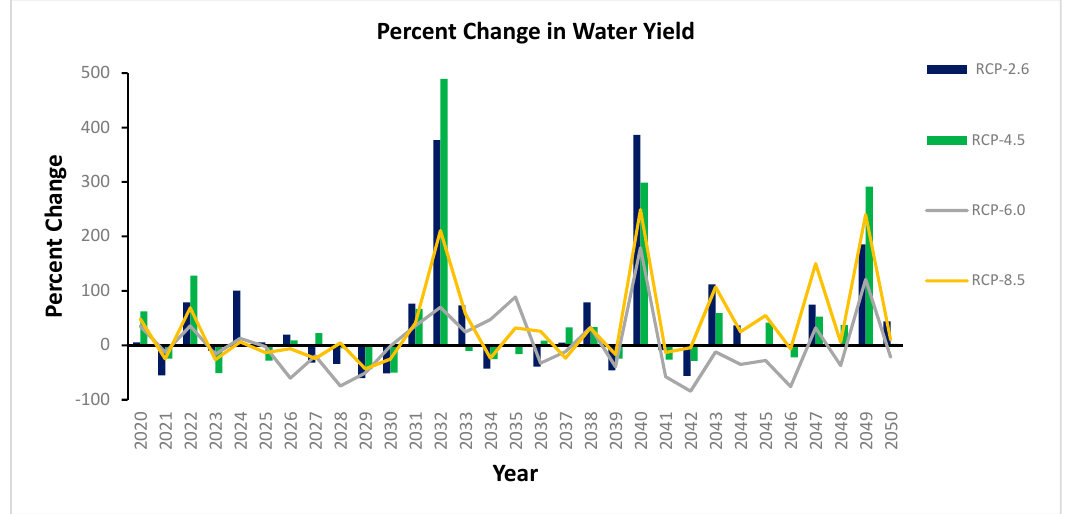
Figure 10. Percent change in water yield comparison under historical and future scenarios.